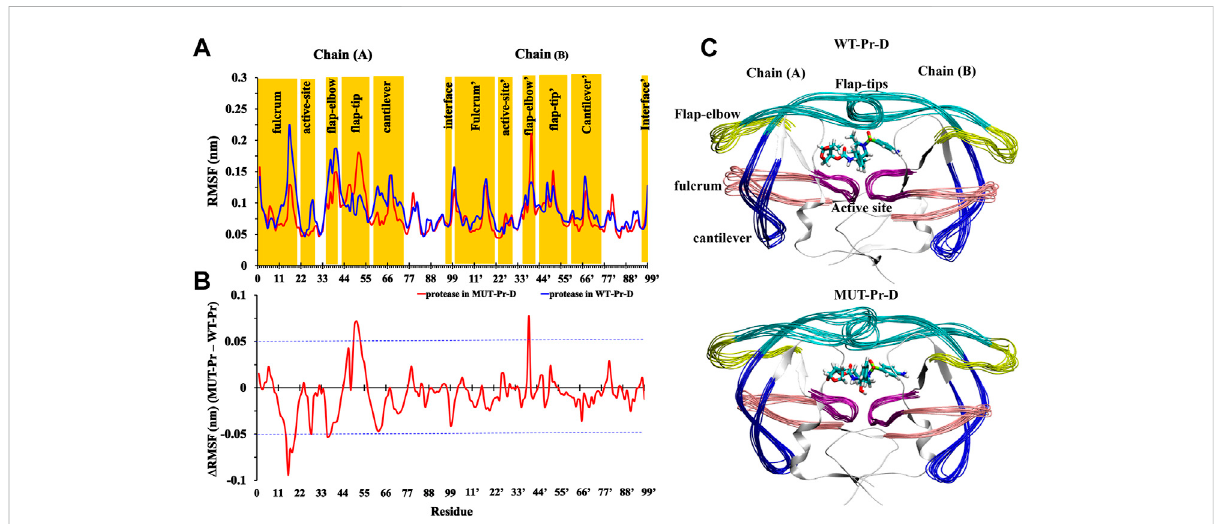
FIGURE 1 (A) RMSF values of C α atoms of WT-Pr-D (blue) and MUT-Pr-D (red); (B) the difference in RMSF values between MUT-Pr-D and WT-Pr-D were illustrated and residues with an absolute difference larger than 0.05 nm (exceeding the blue cutoff lines) were considered as highly fl uctuated; (C) 10 superimposed trajectories snapshots of WT-Pr-D and MUT-Pr-D with 2 ns intervals were